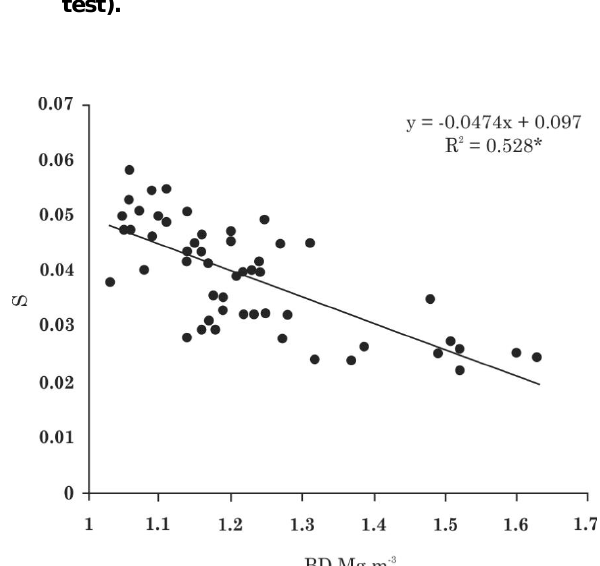
Figure 5. S index as a function of the density of an Oxisol under management systems (n = 105; *: the fitted model was significant at p <0.05 by the F